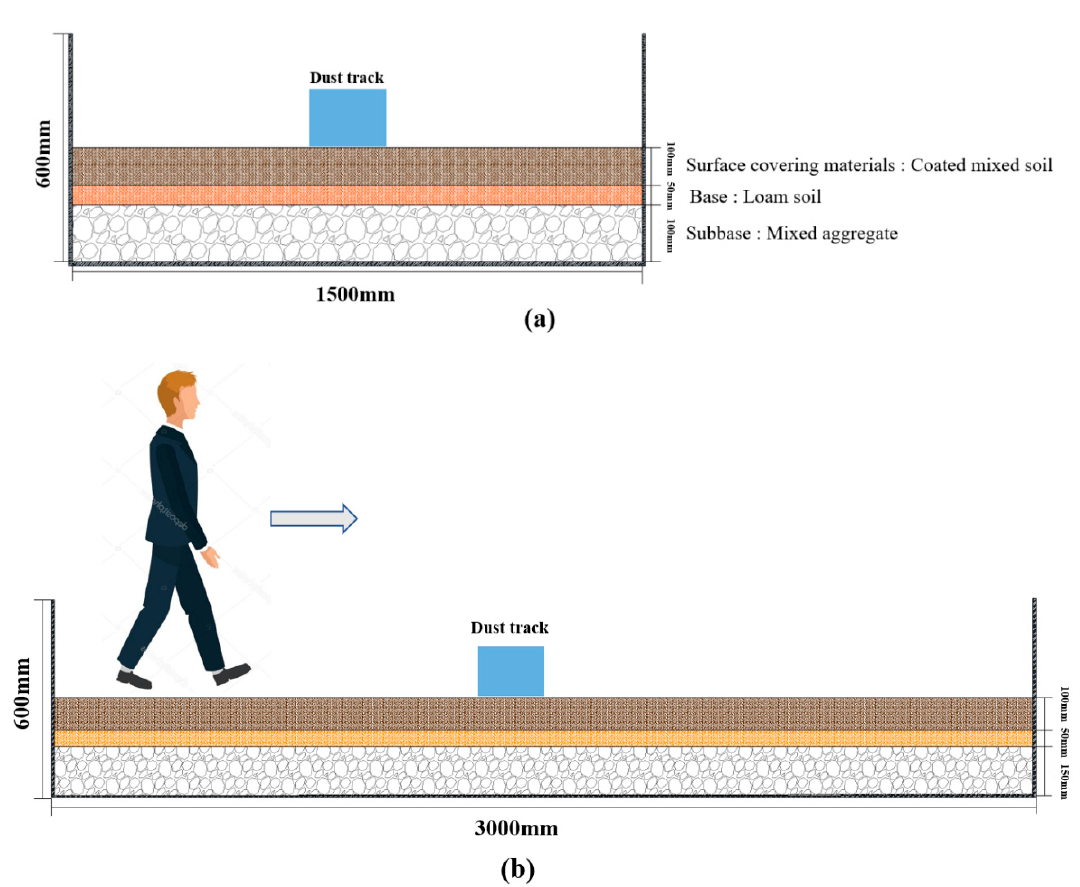
Figure 5. Dust measurement setup due to human activity ( a ) Front view and ( b ) Side view.